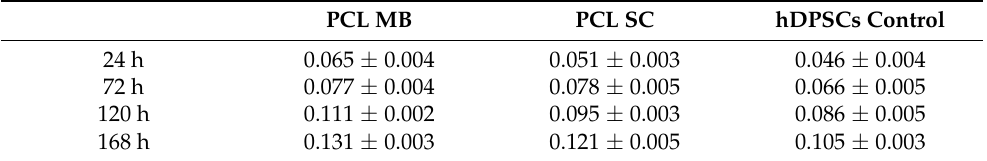
Figure 7. Preliminary cytocompatibility assessment of the PCL groups by Presto Blue TM viability assay for hDPSCs. The results are presented in mean ± SE. Differences were considered statistically significant at p ≤ 0.05. Results’ significance is presented through the symbol (*), according to the p value, with one or two, corresponding to 0.01 < p ≤ 0.05 and 0.001, respectively. Table 3. Preliminary cytocompatibility assessment of the PCL groups by Presto Blue TM viability assay for hDPSCs. Corrected absorbance results are presented in mean ± SE.